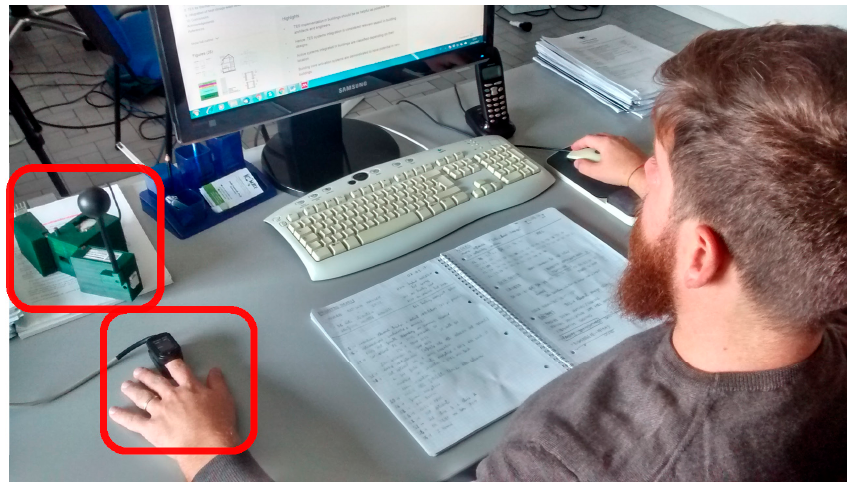
Figure 1. Monitoring system as installed in an office